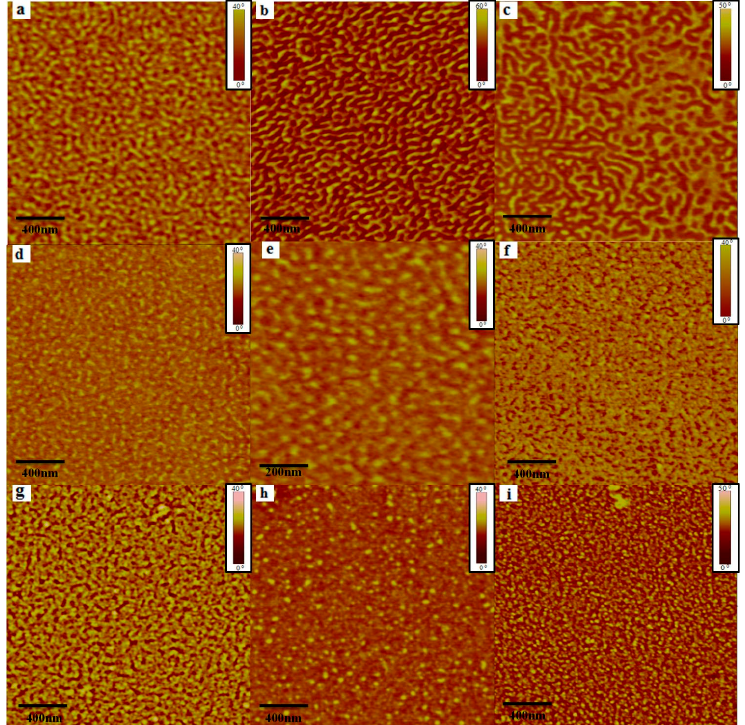
Figure 3. Phase images gallery of as-spun and after specific time duration for SVA treatment of sample PS 45 - b -PB 34 - b -PI 74 /PS_grafted γ -Fe 2 O 3 (10% wt.). The time of treatment in benzene vapors was: ( a ) as-spun, ( b ) 2 h, ( c ) 4 h, ( d ) 18 h ( e ) 18 h (closer view), ( f ) 60 h, ( g ) 96 h, ( h ) 120 h, and ( i ) 192 h. Scan size for all phase images is at 2 µ m × 2 µ m, except from image, ( e ) which corresponds to higher magnification (1 µ m × 1 µ m).